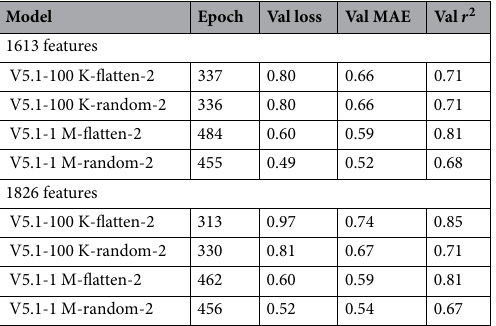
Table 2. Impact of including Mordred 3-D descriptors in the training data for the different sampling